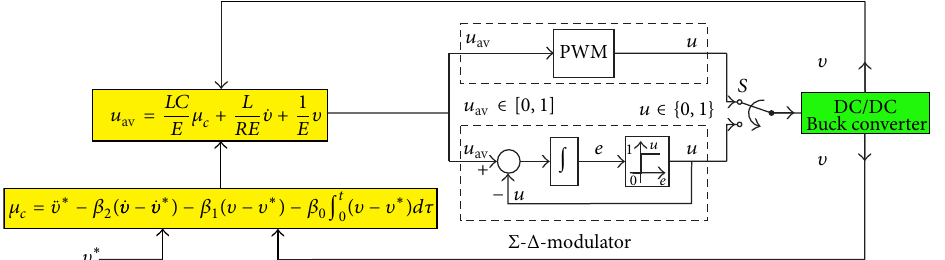
Figure 2: Flatness-based control developed.